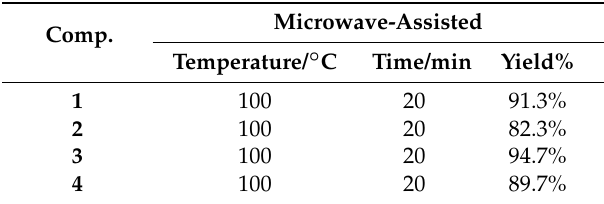
Table 1. The yields of the target complexes by microwave-assisted synthesis method. Comp.